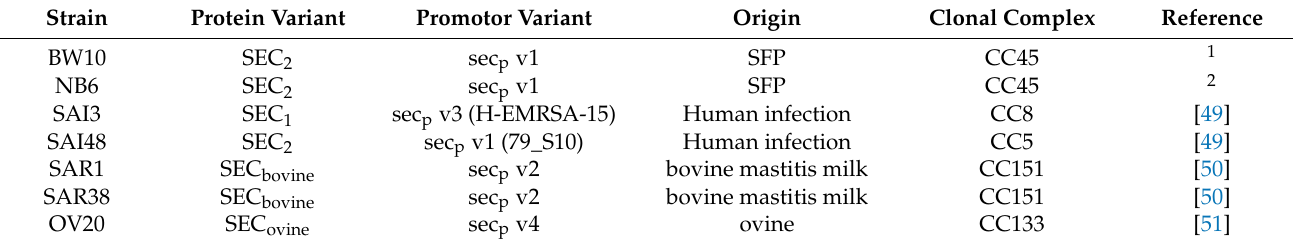
Table 1. Overview of S. aureus strains used in this study including their SEC variants, origin, and clonal complex. 1 Medical Department of the German Federal Armed Forces, Germany. 2 Bavarian State Office of Health and Food Safety,